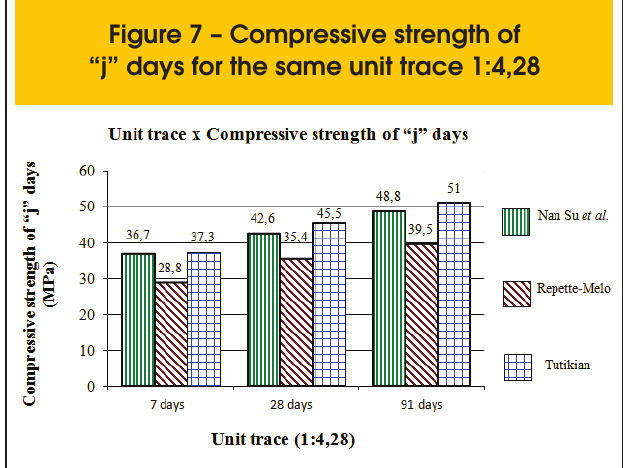
Figure 7 – Compressive strength of “j” days for the same unit trace 1:4,28